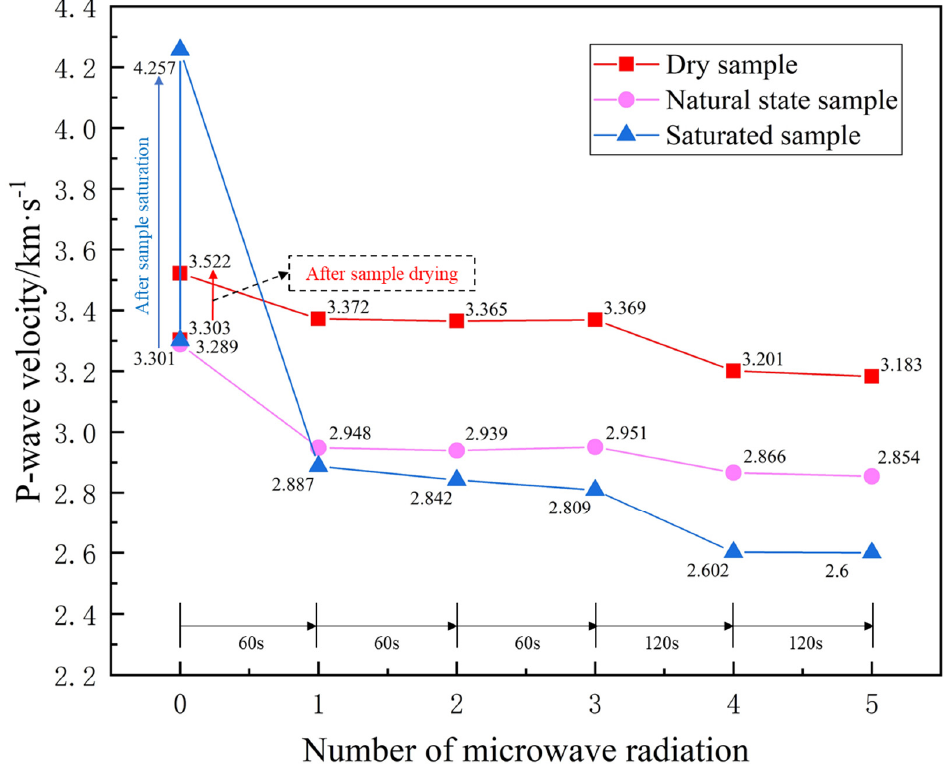
Figure 7. P-wave velocity of sample after microwave cyclic irradiation.